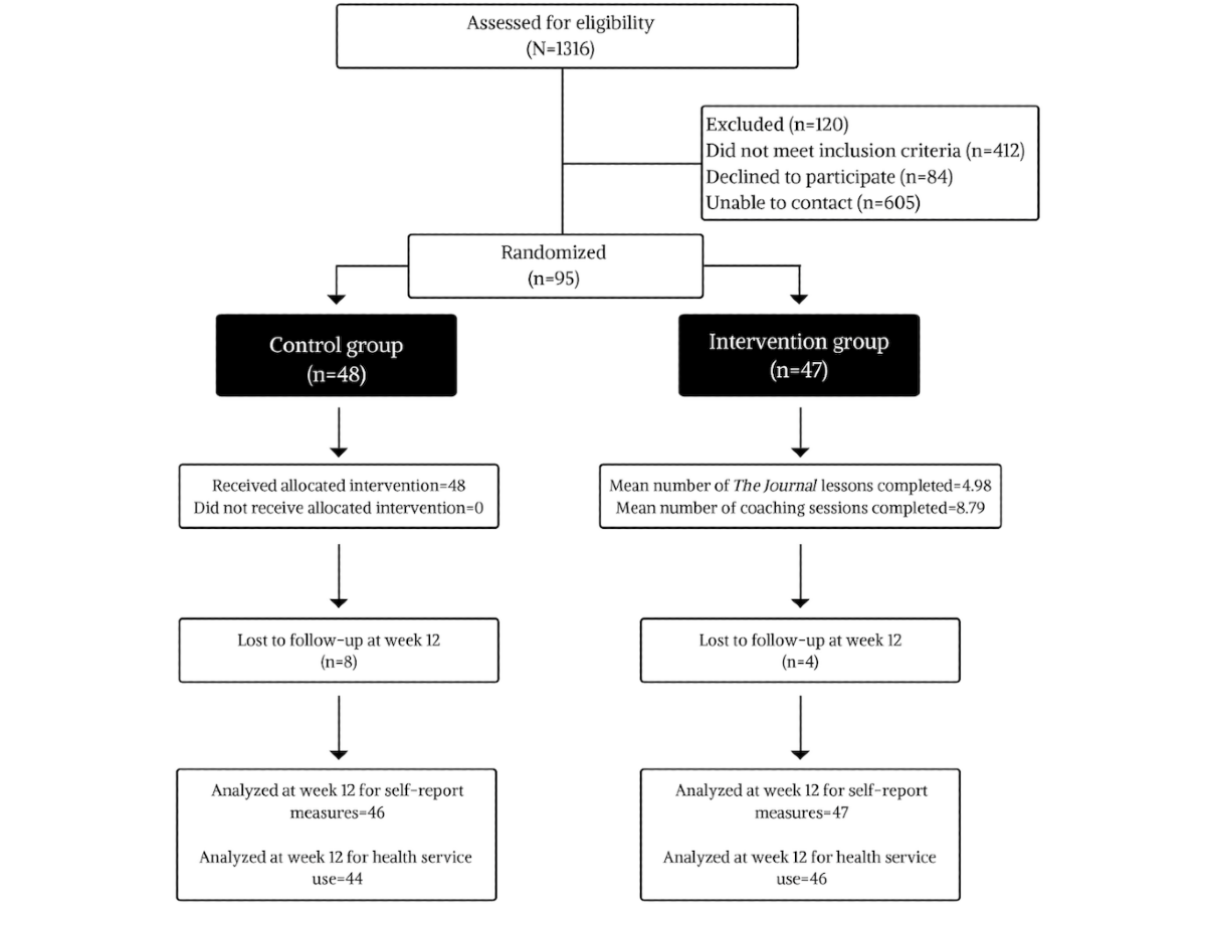
Figure 1. Consolidated Standards of Reporting Trials flow and attrition diagram. CONSORT: Consolidated Standards of Reporting Trials.